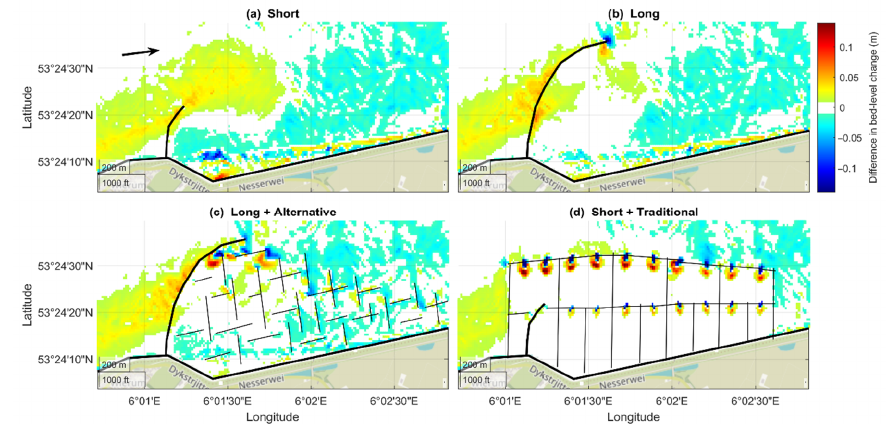
Figure 10. Simulated change in bed level within the study area for the structures ( a ) Short , ( b ) Long , ( c ) Long + Alternative , and ( d ) Short + Traditional . Hard structures in the simulation are depicted by black lines. The arrow indicates the dominant direction of tidal flow and alongshore transport. The lee side is on the right of the structures.